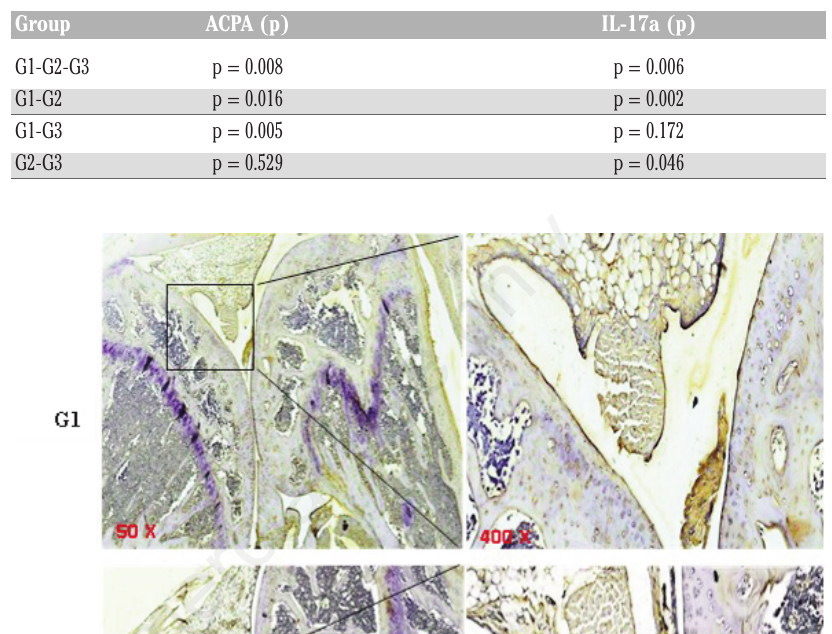
Table 2. Comparative test results of ACPA and IL-17a levels in the experimental groups.